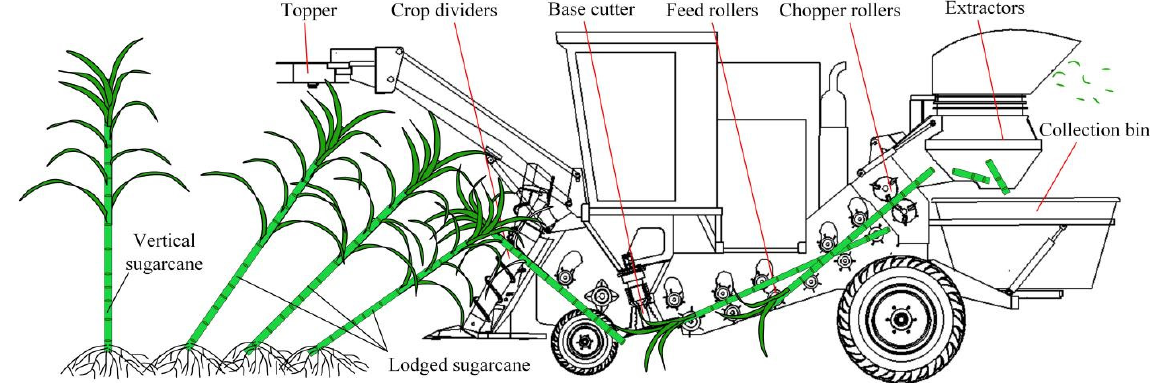
Figure 2. Sugarcane harvester component parts.